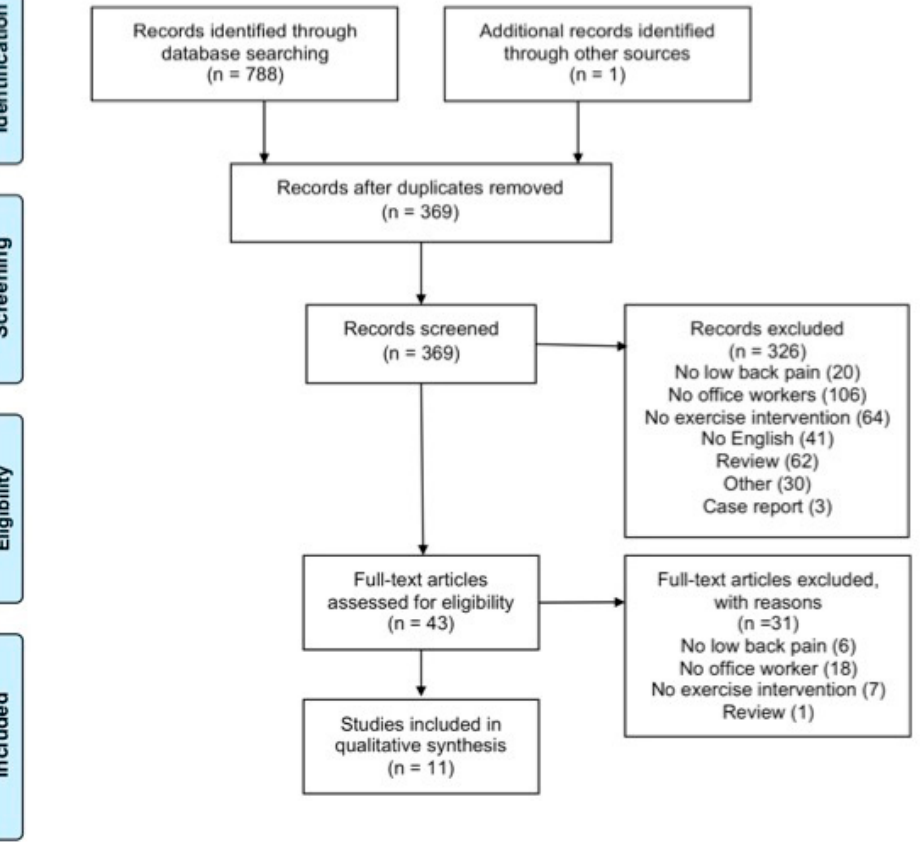
Figure 1. Flow Figure 1. Flow chart. Table 2. Quality assessments of intervention studies.